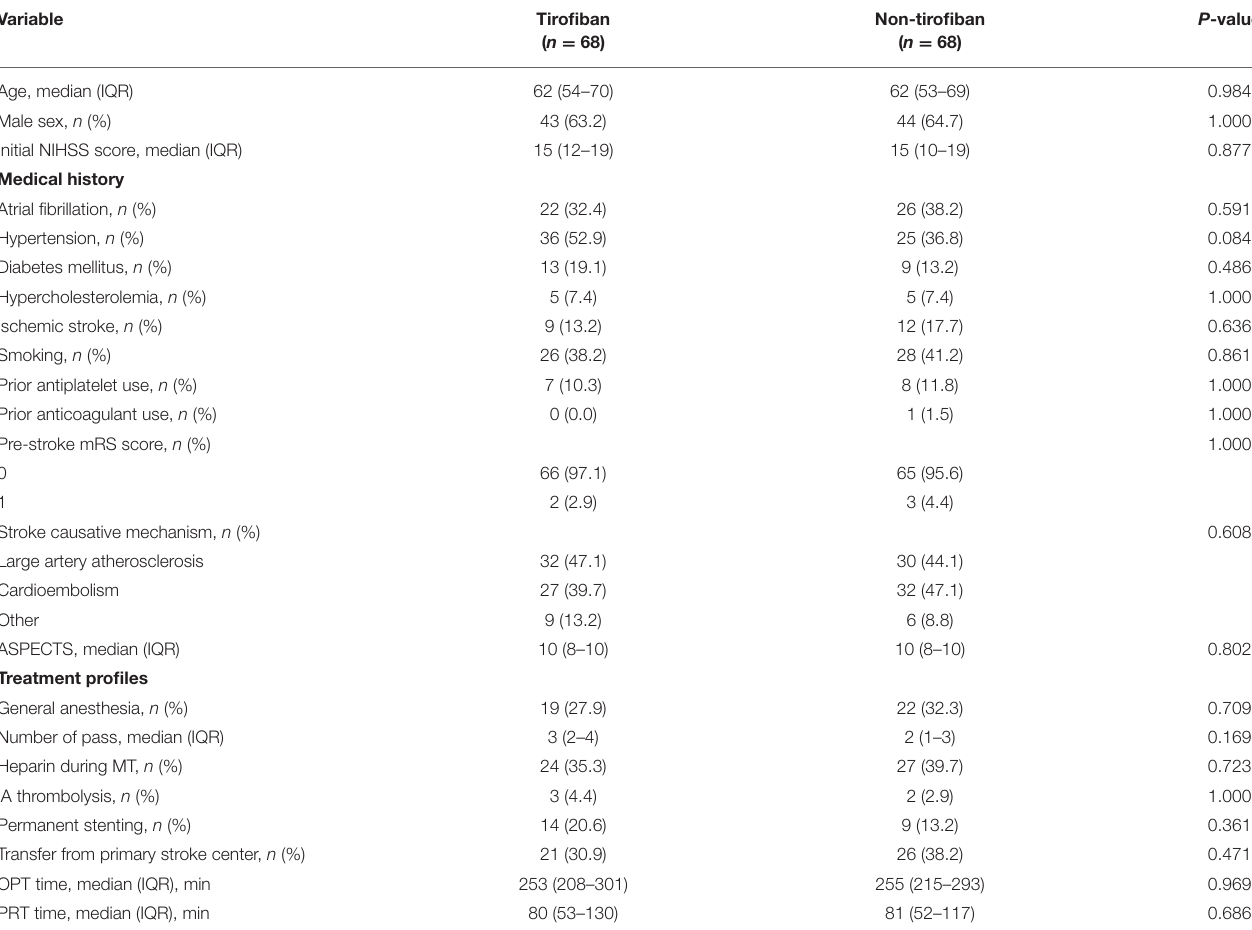
TABLE 2 | Baseline characteristics of patients after